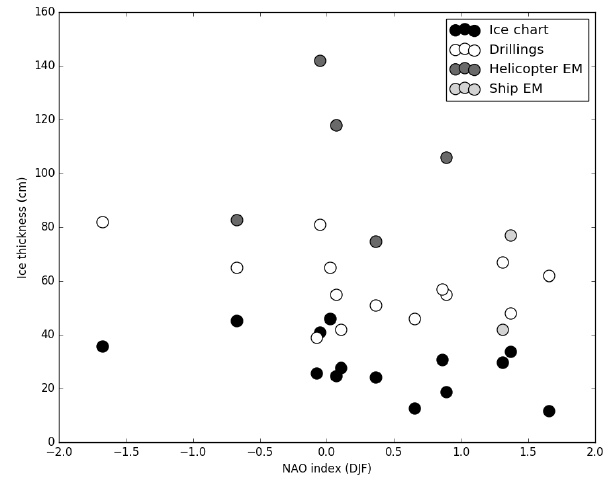
Figure 11. NAO index (DJF) and ice thickness from ice charts (black), drillings (white), helicopter EM surveys (dark grey), and ship EM surveys (light grey) for